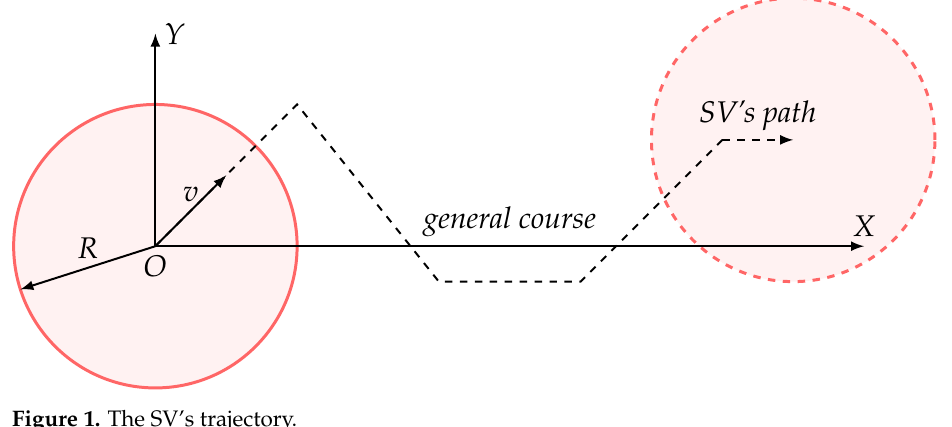
Figure 1. The SV’s trajectory.